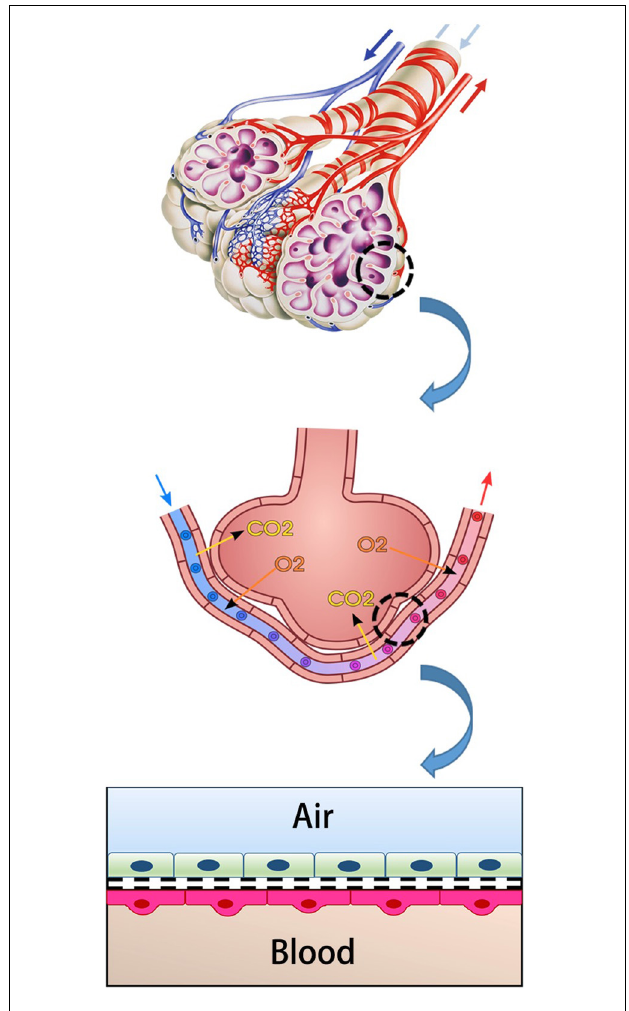
FIGURE 1 | Simplified diagrammatic look of air-blood